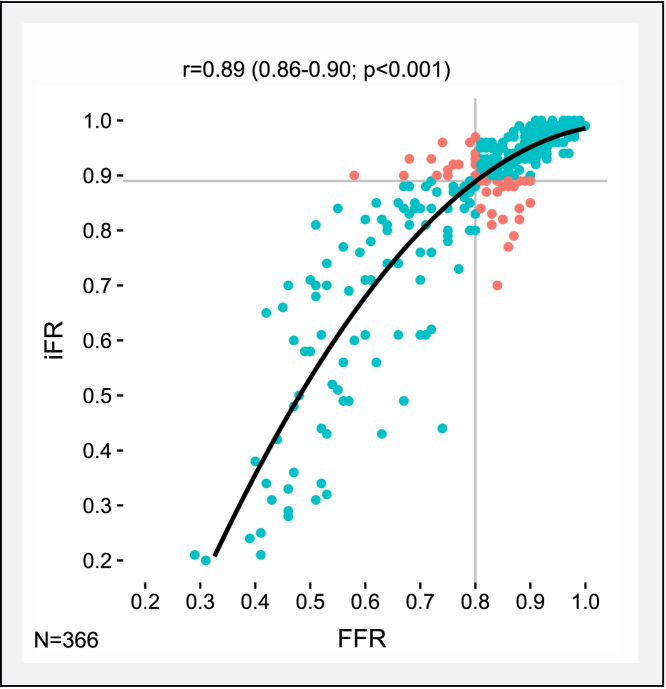
Scatter Plot Showing the Relationship Between FFR and iFRThe black line represents the line of best fit. The curve is fitted by second-order polynomial. The gray lines represent the respective cutoff values for FFR (≤0.80) and iFR (≤0.89). Concordant cases are colored blue, discordant cases are colored orange. Abbreviations as in Figure 1.